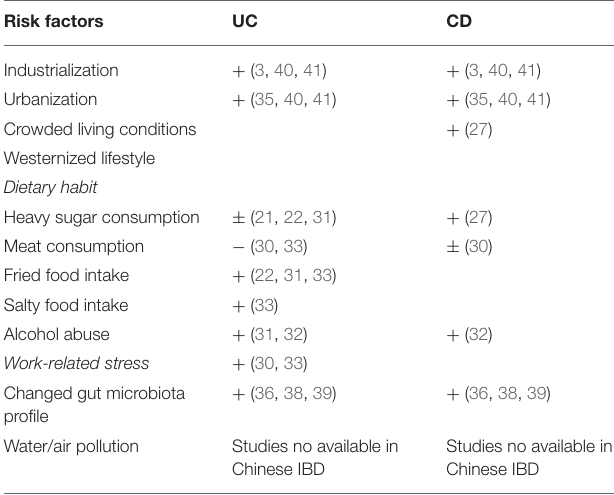
TABLE 3 | Changes in gut microbiota profile in relative with Westernized diet and urbanization in Chinese.